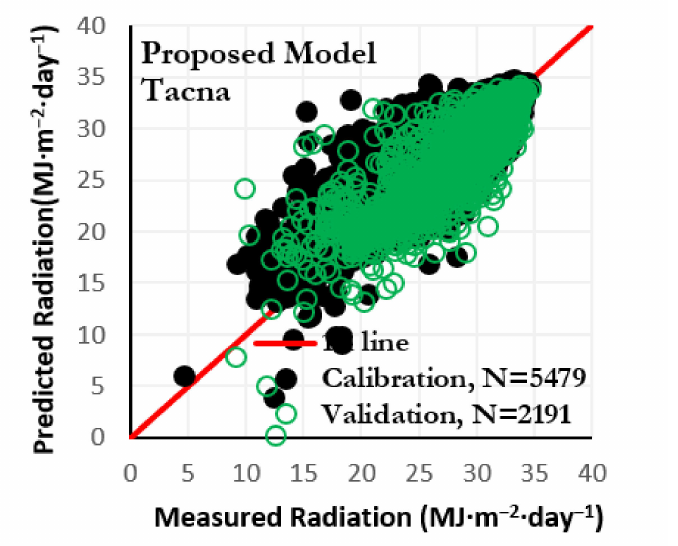
Figure 14. Solar radiation estimated by proposed model at Tacna station versus measured values in calibration and validation